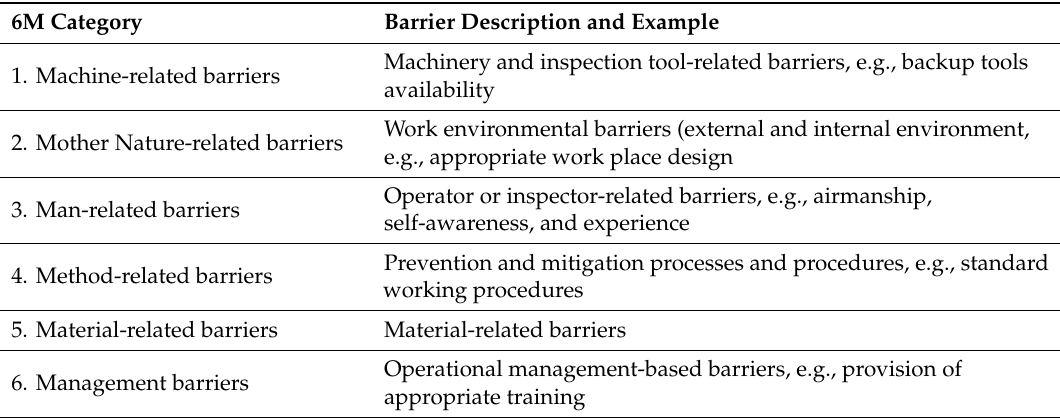
Table 5. The 6M categories for prevention and mitigation barriers with example.